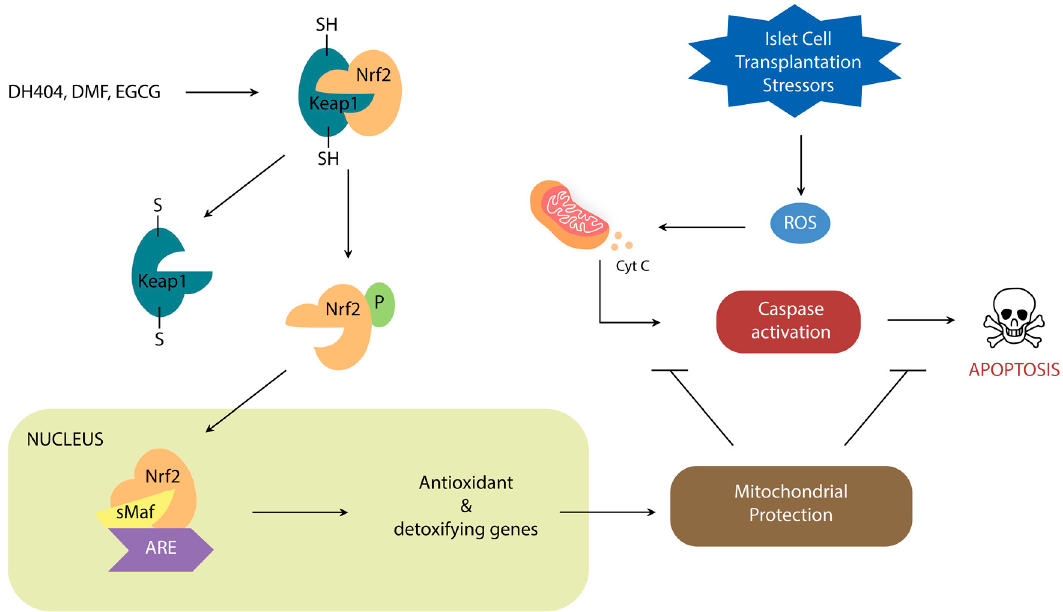
Figure 1. Schematic demonstrating the role of Nrf2/Keap1 signal transduction on oxidative stress